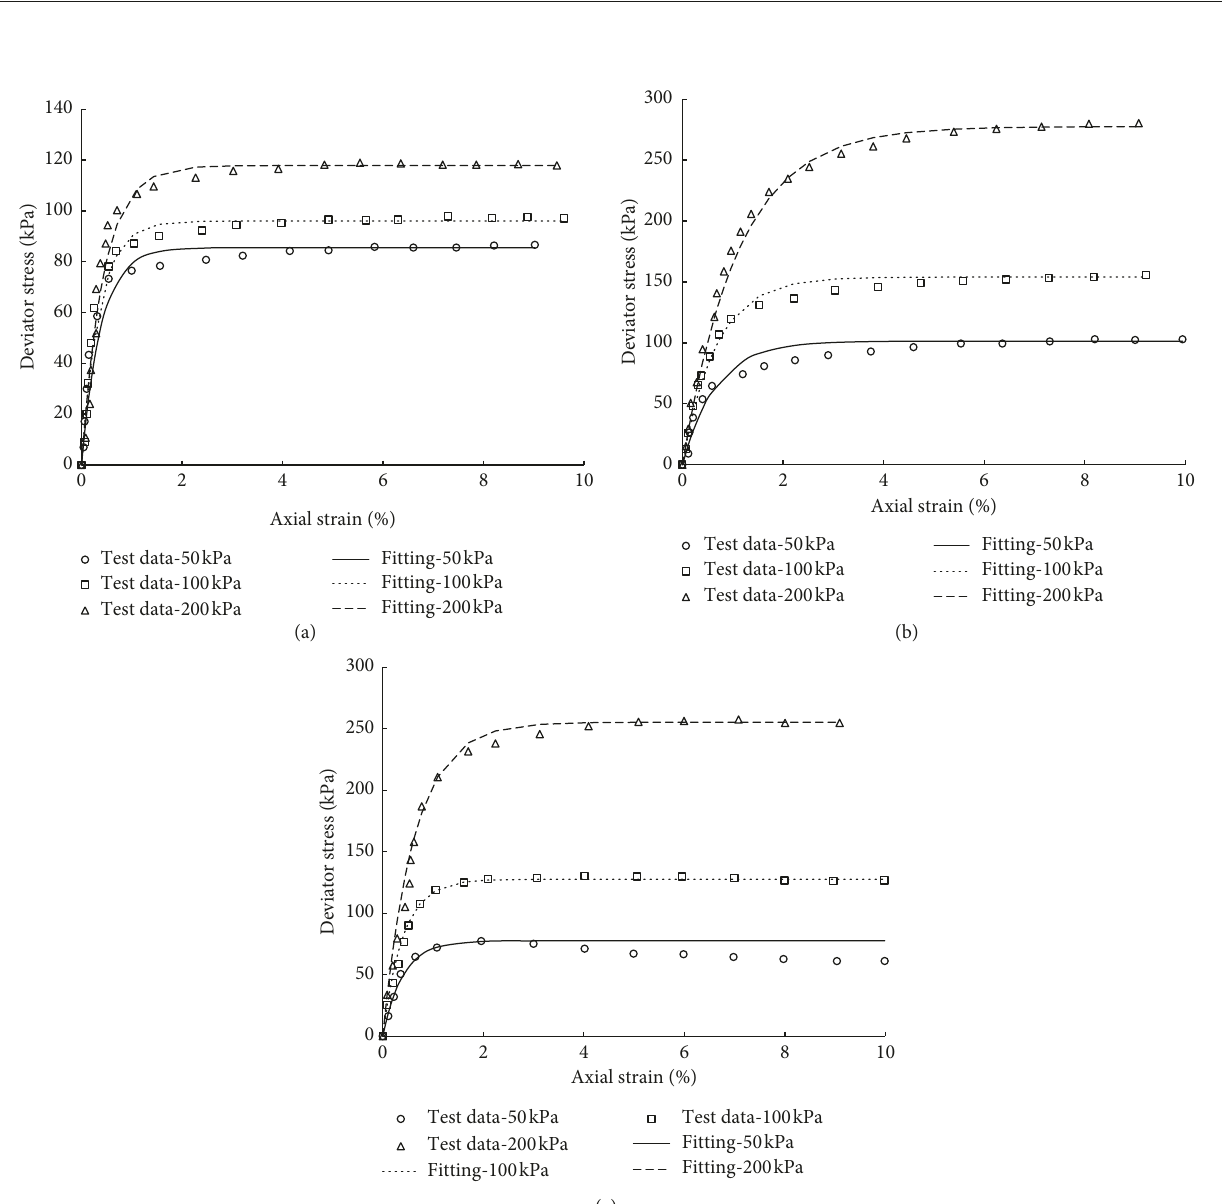
Figure 13: Fitting curves for data from the triaxial shear test: (a) unconsolidated-undrained triaxial shear test; (b) consolidation-undrained triaxial shear test; (c) consolidation-drained triaxial shear